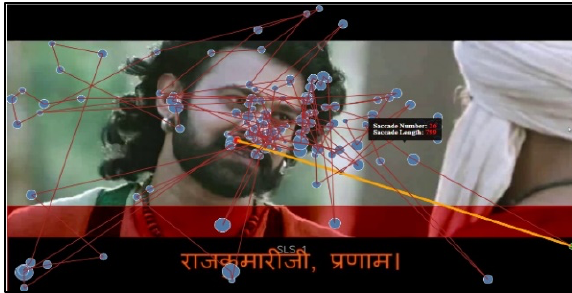
Figure 1: Selection of longest saccade in the main canvas